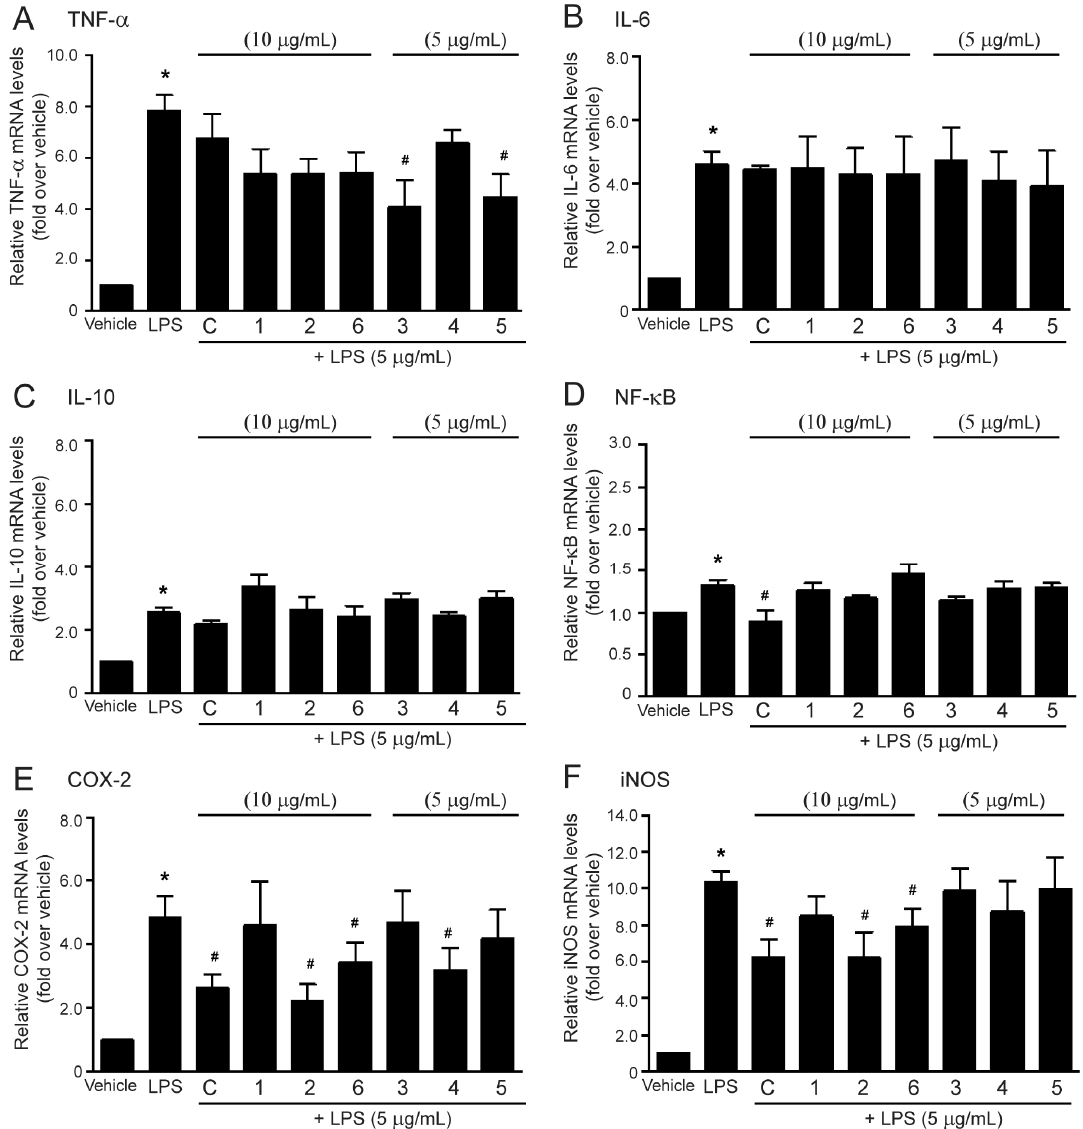
Figure 6. Effects of the methanol extract and isolated lignans 1 − 6 from M. sirikitiae leaves on LPS- induced mRNA expressions of inflammatory biomarkers in RAW 264.7 cells; Serum-starved cells were pretreated with crude methanol extract (C) (10 µg/mL) or lignans (5 or 10 µg/mL) for 3 h, and then stimulated with LPS for 6 h at 37 °C. After treatment, the total RNA was extracted from the cells and the mRNA expressions of TNF- α ( A ), IL-6 ( B ), IL-10 ( C ), NF- κ B ( D ), COX-2 ( E ), and iNOS ( F ) were analyzed by RT-qPCR with gene-specific primers. The relative mRNA levels were quantified and shown as the mean ± SEM ( n = 3). *, p < 0.05 vs. vehicle; #, p < 0.05 vs. LPS.